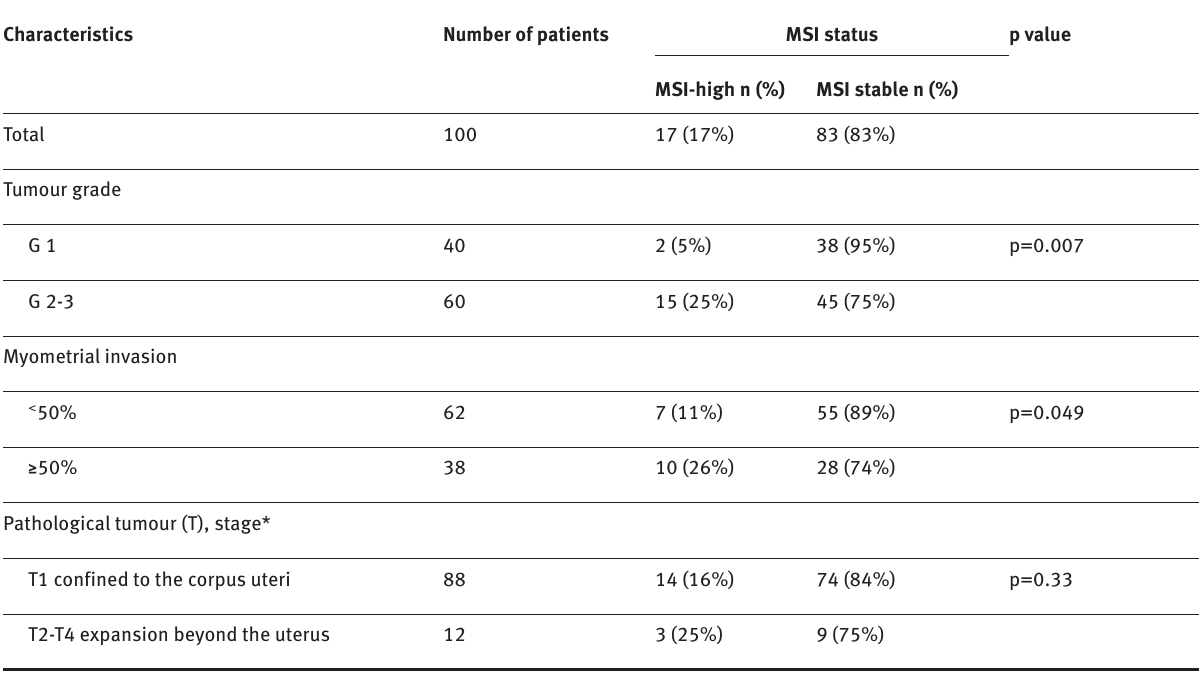
Table 2: Clinicopathologic characteristics according to the microsatellite instability (MSI) status in endometrioid type adenocarcinomas